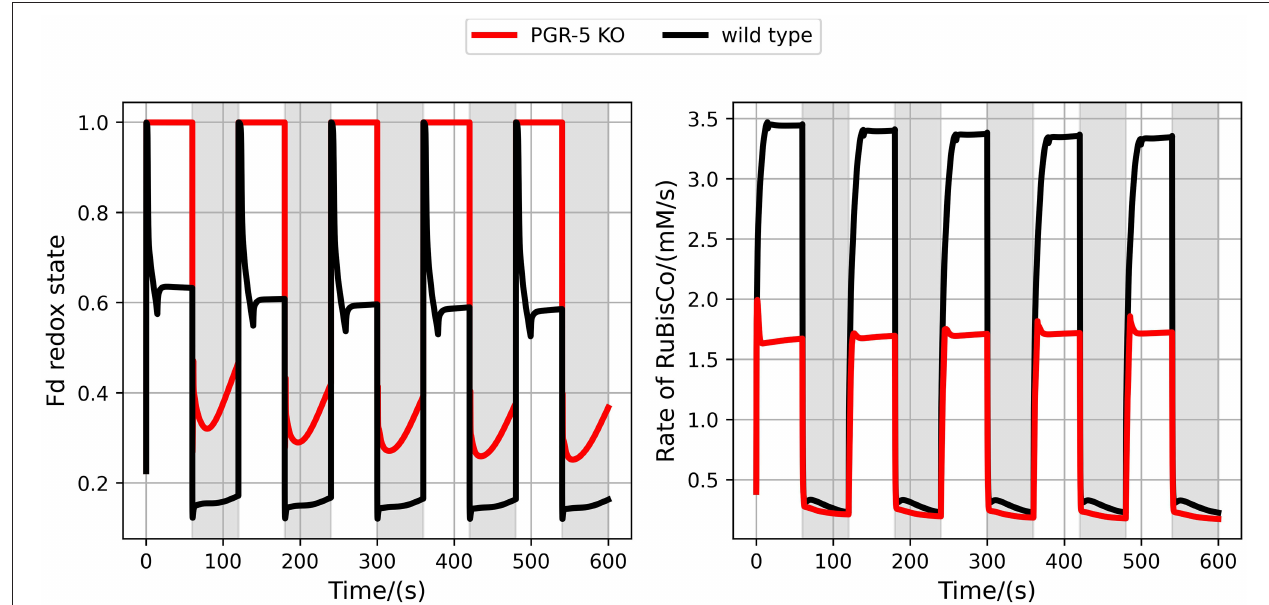
FIGURE 5 | Simulating fluctuating light for the wildtype and the PGR5 knockout (KO) mutant. Shown are the Fd redox state (left) and the RuBisCO activity (right) for the wildtype (black) and the PGR5 knockout (red). Light intensities were changed every 60s between high light (PPFD 600 µ molm − 2 s − 1 , white regions) and low light (PPFD 40 µ molm − 2 s − 1 , grey